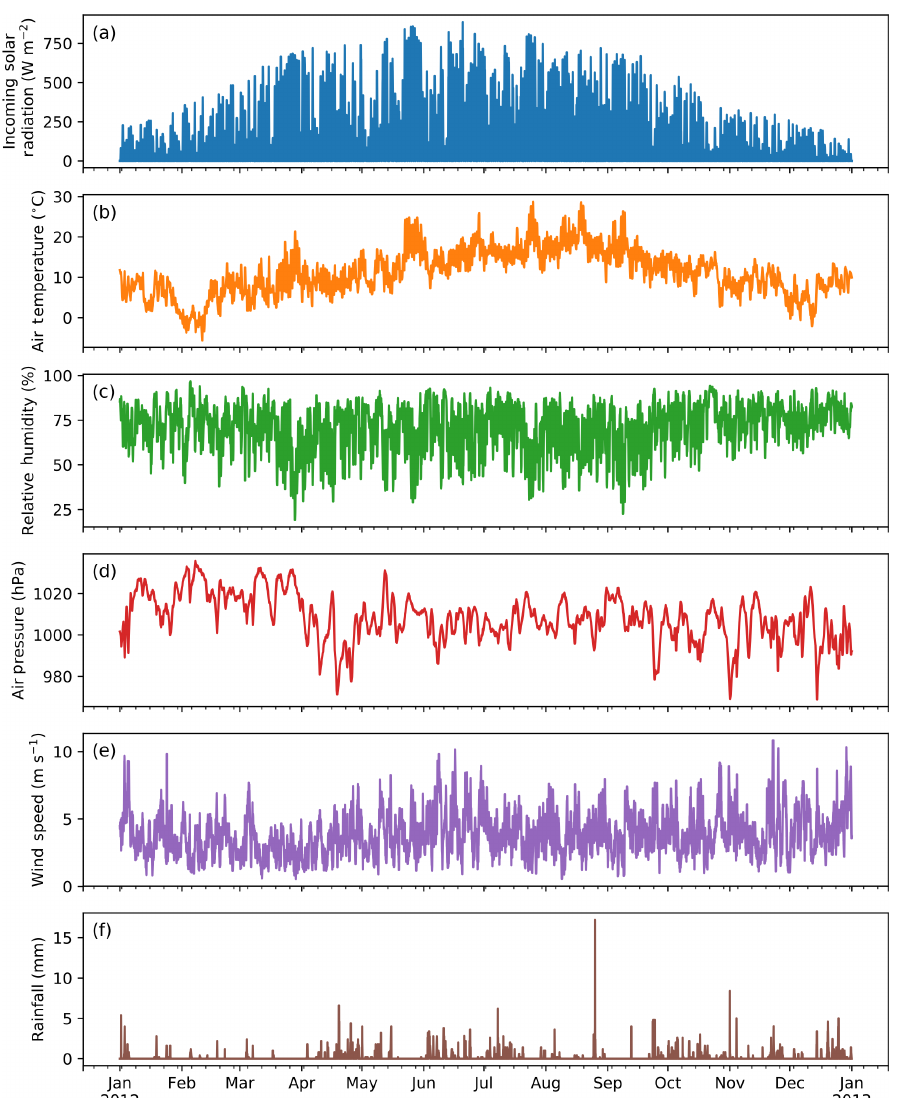
Figure 2. Intra-annual (2012) variation in forcing variables in the sample dataset (from top to bottom): incoming solar radiation, air tem- perature, relative humidity, air pressure, wind speed and rainfall in central London All variables are hourly averages except for total hourly rainfall (source of data: Kotthaus and Grimmond, 2014; gap filled: Ward et al.,